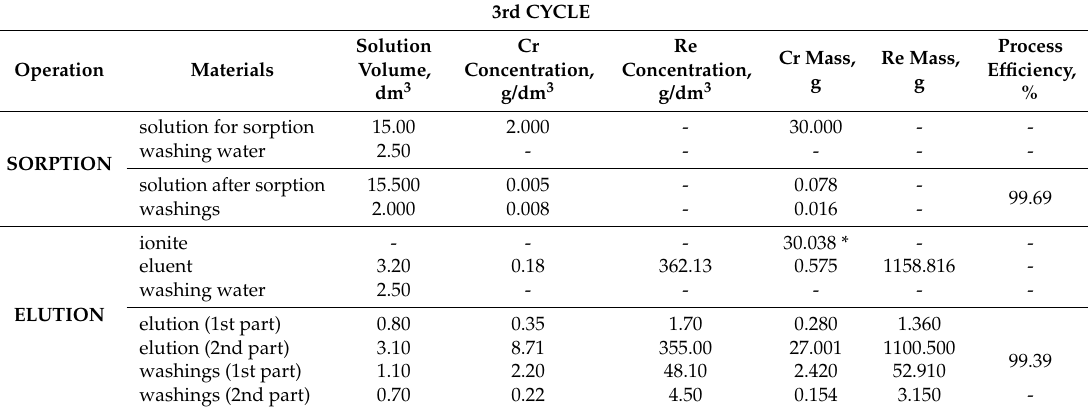
Table 3. Chromium(III) sorption and elution balance—3rd cycle. 3rd